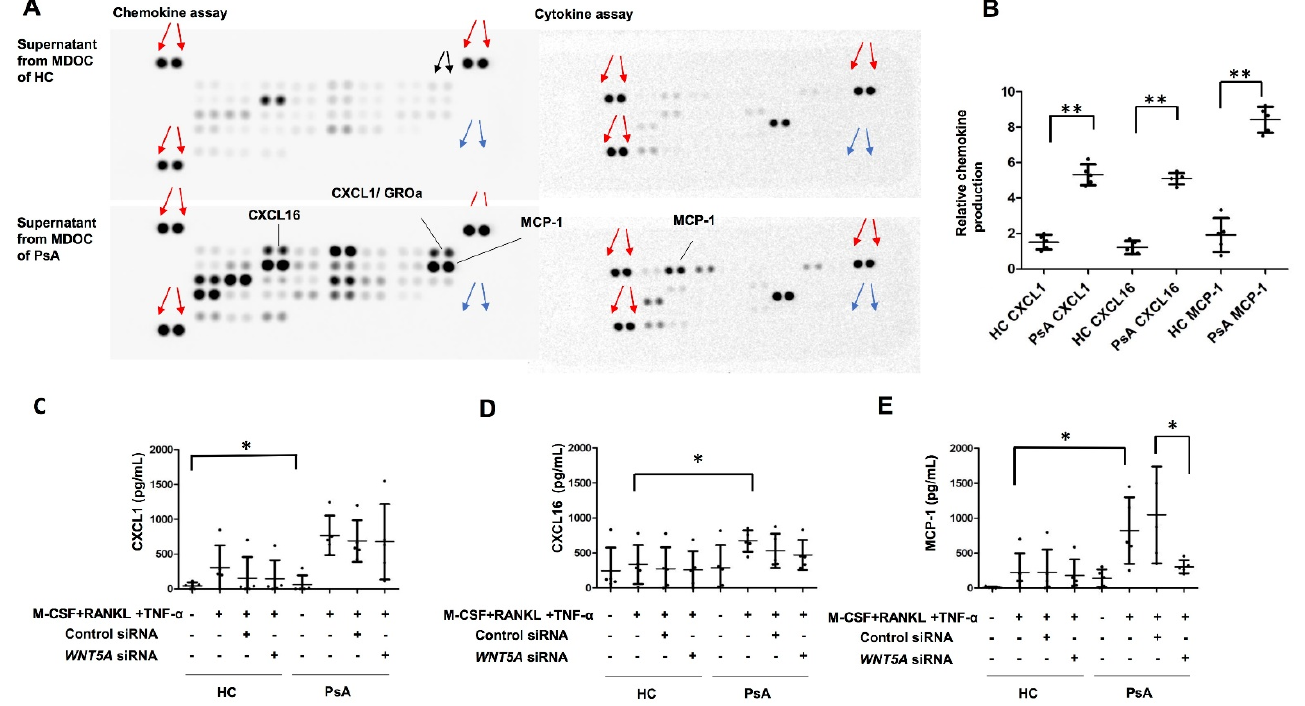
Figure 3. Increased MCP-1 level in supernatants of MDOC from patients with PsA was abrogated by WNT5A RNA interference. ( A ) The culture supernatants from MDOC from PsA patients ( n = 5) and HC ( n = 5) on Day 13 were assayed using a human cytokine array. Positive controls were marked by red arrows, while the negative controls were marked by blue arrows. The dot marked as black arrows represents the fold change of 1. The average signal intensity of each pair of cytokine spots was quantified using ImageJ and is expressed as the fold change relative to the data for HC. ( B ) CXCL1, CXCL16, and MCP-1 levels in the supernatants from MDOC of PsA patients and of HC were quantified using the data from ( A ) with ImageJ. ( C – E ) MDOC from PsA patients ( n = 5) or HC ( n = 5) were obtained by incubation with M-CSF, RANKL, and TNF- α , with transfection of control siRNA or WNT5A siRNA. CXCL1 ( C ), CXCL16 ( D ), and MCP-1 ( E ) levels were determined using ELISA in culture supernatants from monocytes or MDOC with RNA interference. The error bar representes the standard deviation of each data set. * indicates p < 0.05, and ** indicates p <